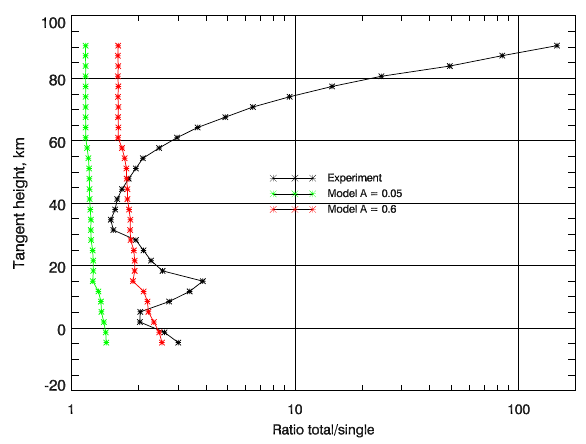
Figure 8. Vertical Na density profiles for the D 1 and D 2 lines and for different constraint parameters (same conditions as in Fig. 6, albedo factor 1.2; see legend for constraint parameter value).